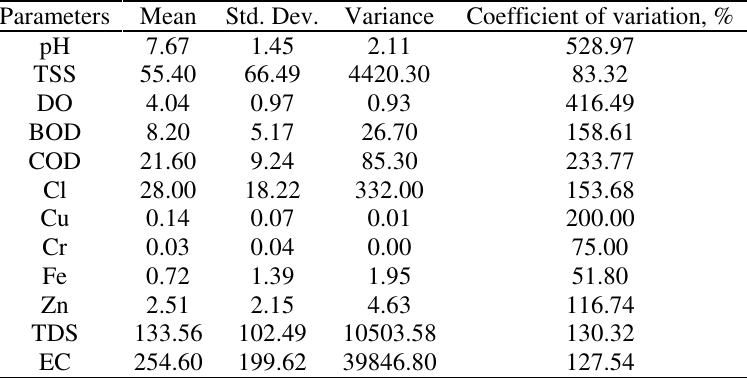
Table 3. Descriptive statistics of wastewater analysis